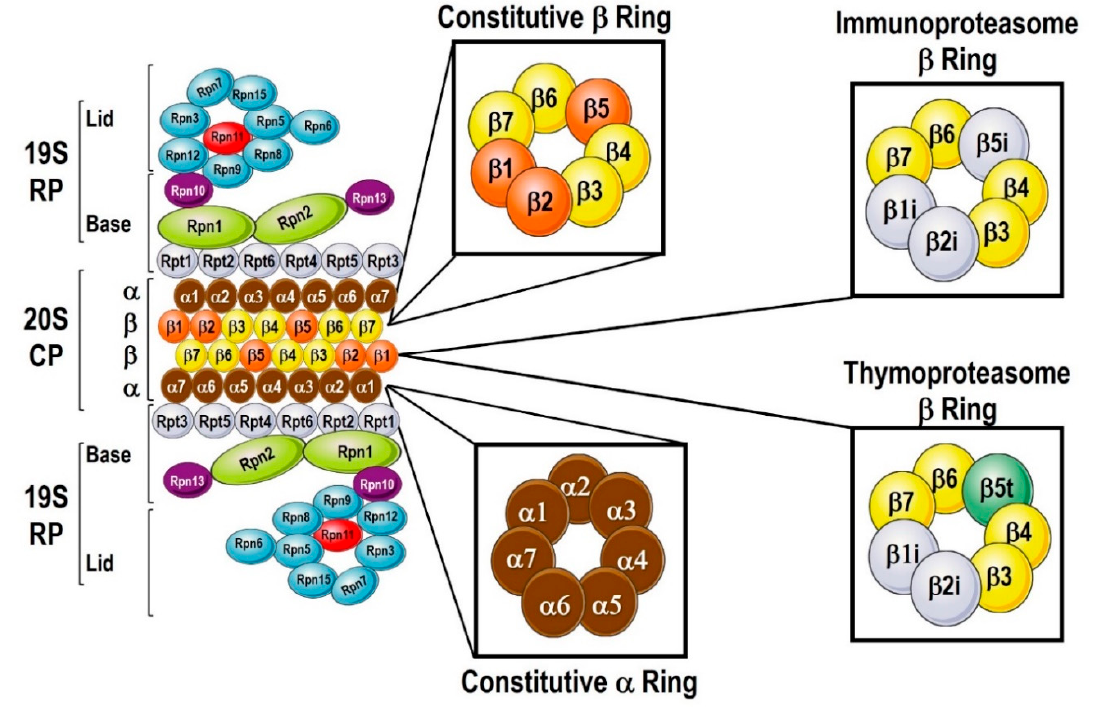
Figure 1. Proteasomal components. The proteasome can be divided into the 2 main structures: the 20S core protease (CP) and the 19S regulatory particle (RP). The 20S consists of α and β subunits, with 7 α -subunits forming the α -ring, and 7 β -subunits forming the β -ring. When the immunoproteasome is activated, there are 3 β -subunits that are replaced, β 1i for β 1, β 2i for β 2, and β i for β to form the Immunoproteasome. The CP in the thymus is equipped by β 5t instead of the β 5. The 19S RPs is a protein-complex made out 6 subunits of Rpt and 13 subunits of Rpn proteins important to keep the 20S CP open and to bind and process ubiquitylated proteins for degradation.